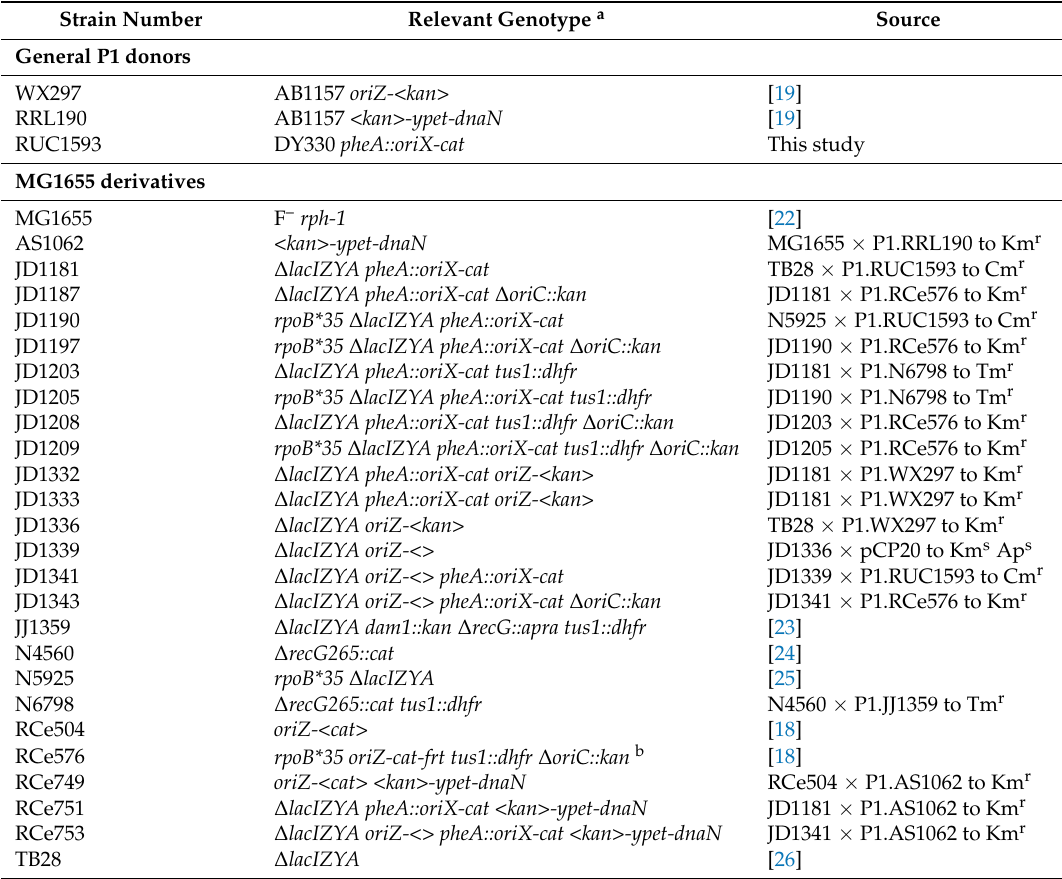
Table 1. Escherichia coli K-12